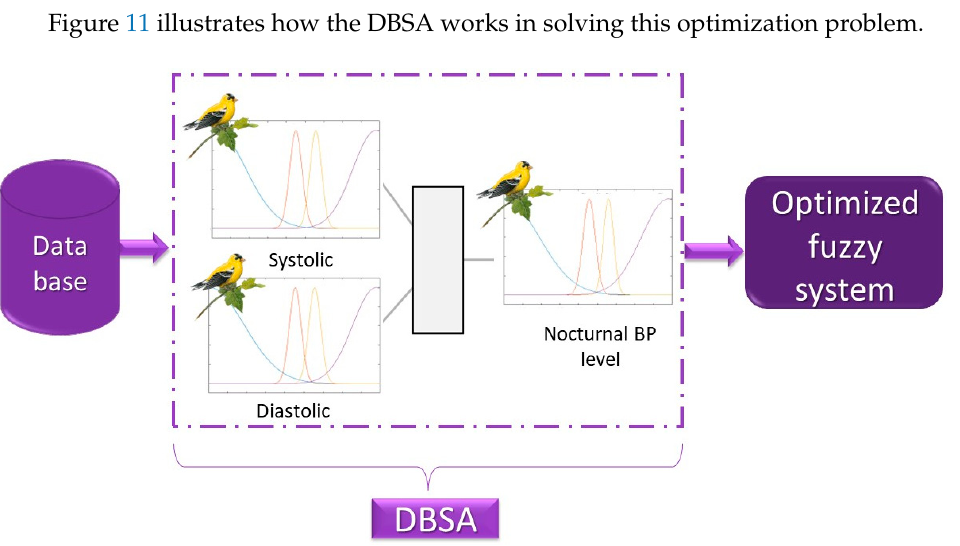
Figure 11. DBSA applied in the optimization of fuzzy system.